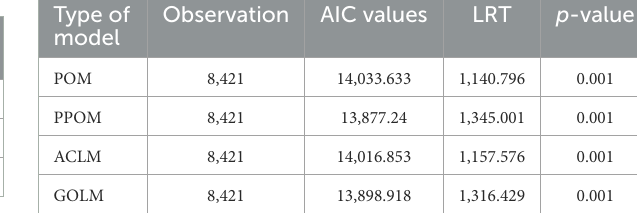
indicates significant hot spot (high-risk) areas for anemia and the blue color indicates the cold spot (low-risk) areas of anemia (Figure 7).